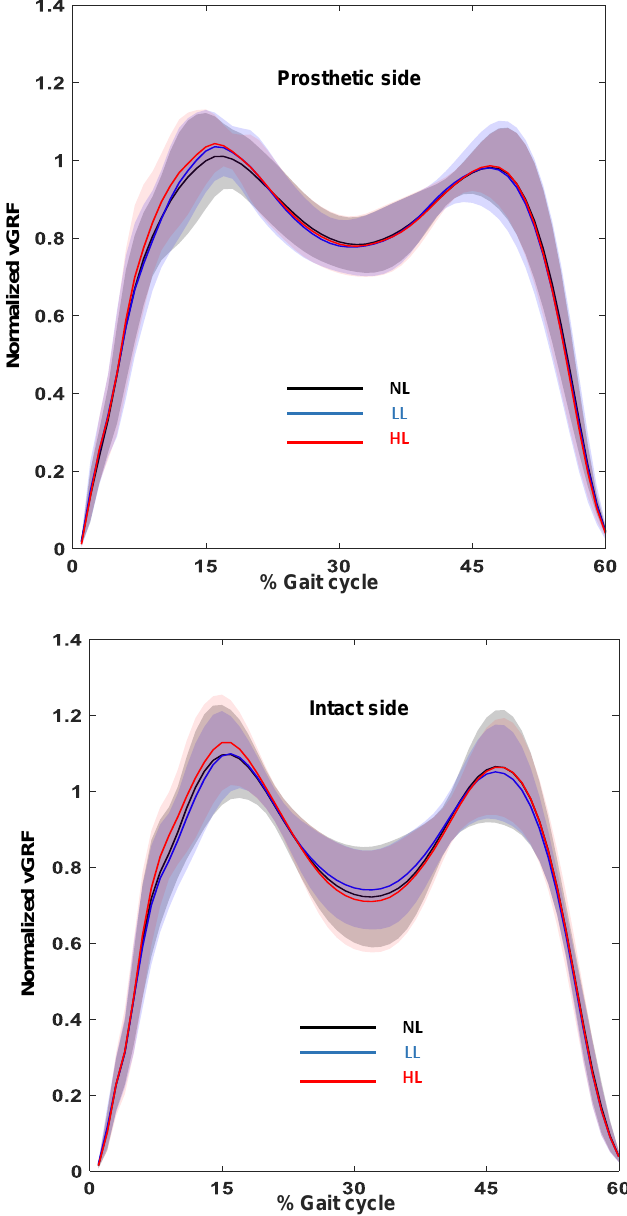
Figure 3: Mean normalized vGRF activity of the prosthetic (A) and intact side (B) across the three load conditions (NL, LL and HL). The shaded region represents 1±SD of the group mean 27 for that load condition. NL= No load, LL= Light load, HL= Heavy